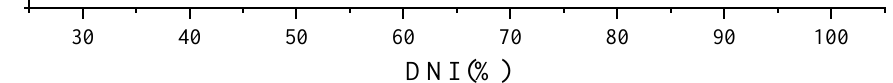
Figure 8. Trend of solar photoelectric efficiency with DNI reduction for the optimal model of system/solar photoelectric efficiency under design load.